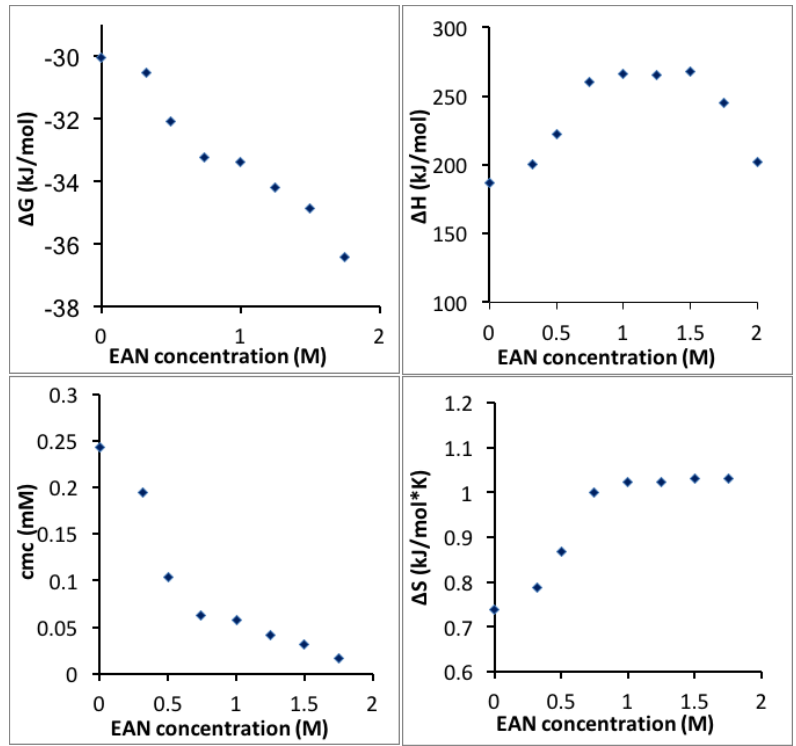
Figure 6. Δ G mic , Δ H mic , Δ S mic and CMC of Pluronic P123 micellization in EAN aqueous solution Figure 6. ∆ G mic , ∆ H mic , ∆ S mic and CMC of Pluronic P123 micellization in EAN aqueous solution plotted as a function of EAN concentration. plotted as a function of EAN